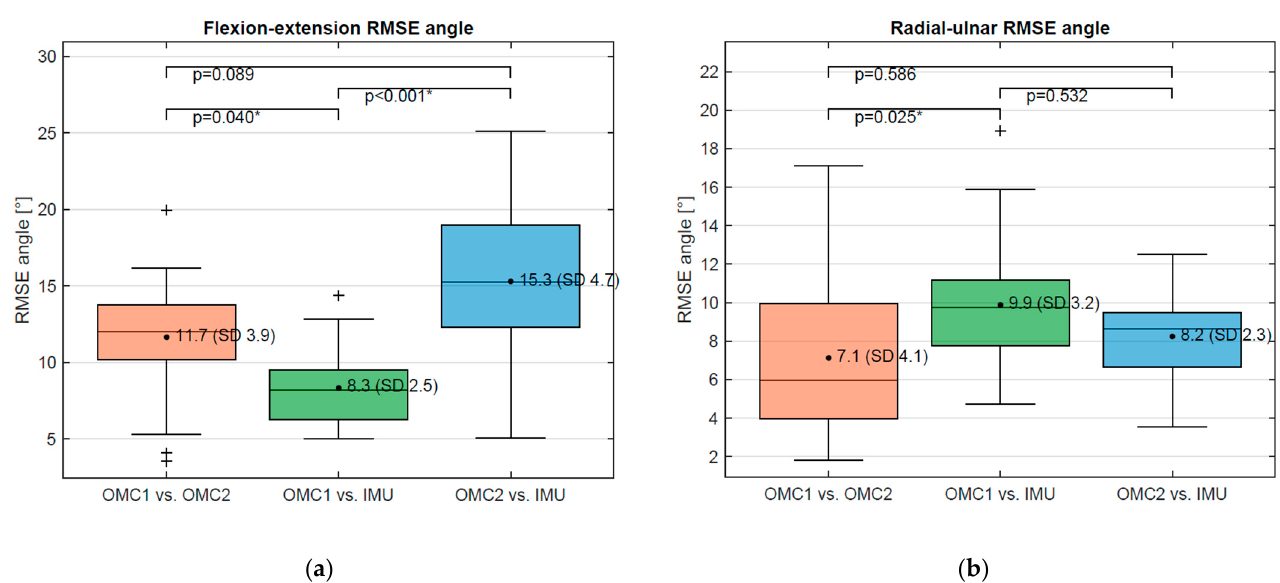
Figure 6. ( a ) RMSE of flexion–extension angle between OMC1, OMC2, and IMU acquisition systems and ( b ) RMSE of radial–ulnar deviation angle between OMC1, OMC2, and IMU acquisition systems. For Values marked as *, the difference is statistically significant. The symbols are statistical outliers and can be captioned as such.